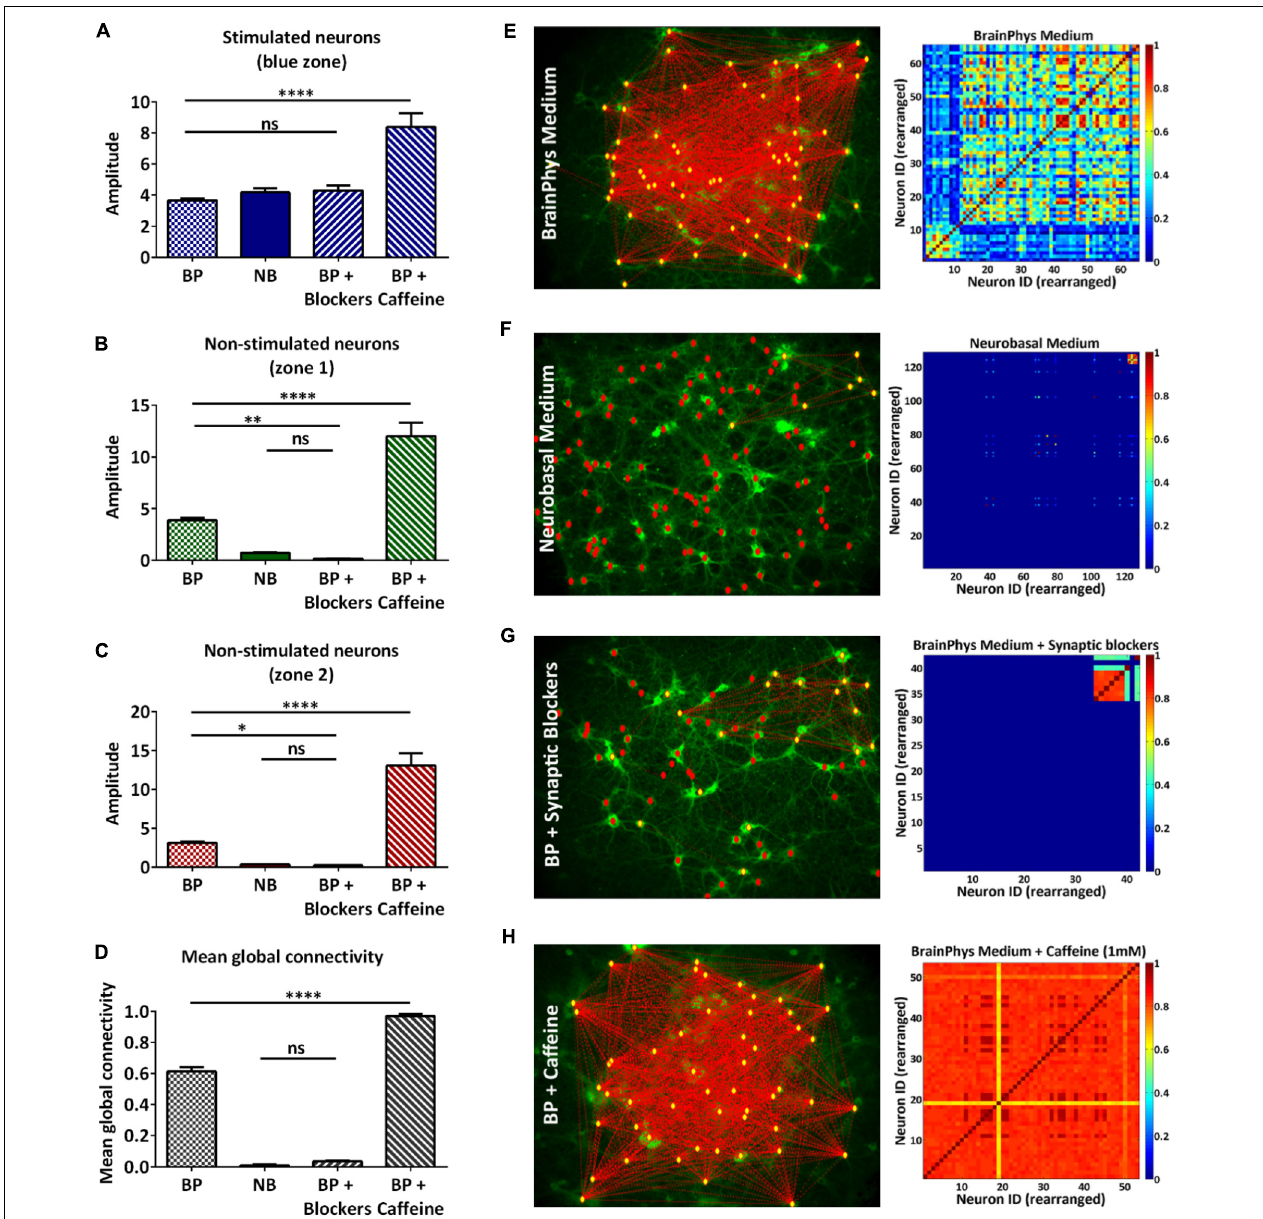
FIGURE 4 | Qualitative and quantitative analysis of neural network connectivity. (A–C) Average of the amplitude of the calcium events of multiple individual neurons in the same zone ± s.e.m.: stimulated neurons (A) , non-stimulated neurons in zone 1 (B) , and zone 2 (C) during the 100 ms pulses protocol in four conditions: BrainPhys complete medium (BP), complete Neurobasal medium (NB), synaptic blockers (BP + blockers) and caffeine (BP + caffeine) ( n= 3 independent cell culture experiments for each condition; one-way ANOVA, (A) F (3,36) = 20.16, P < 0.0001; (B) F (3,36) = 66.31, P < 0.0001 (C) F( 3,36) = 59.77, P < 0.0001; (A–C) followed by Tukey’s multiple comparisons test: ns=non-significant, ∗ P < 0.05, ∗∗ P < 0.01, ∗∗∗∗ P < 0.0001). (D) Mean global connectivity in BrainPhys complete medium (BP), complete Neurobasal medium (NB), synaptic blockers (BP + blockers) and caffeine (BP + caffeine) conditions. ( n = 3 independent cell